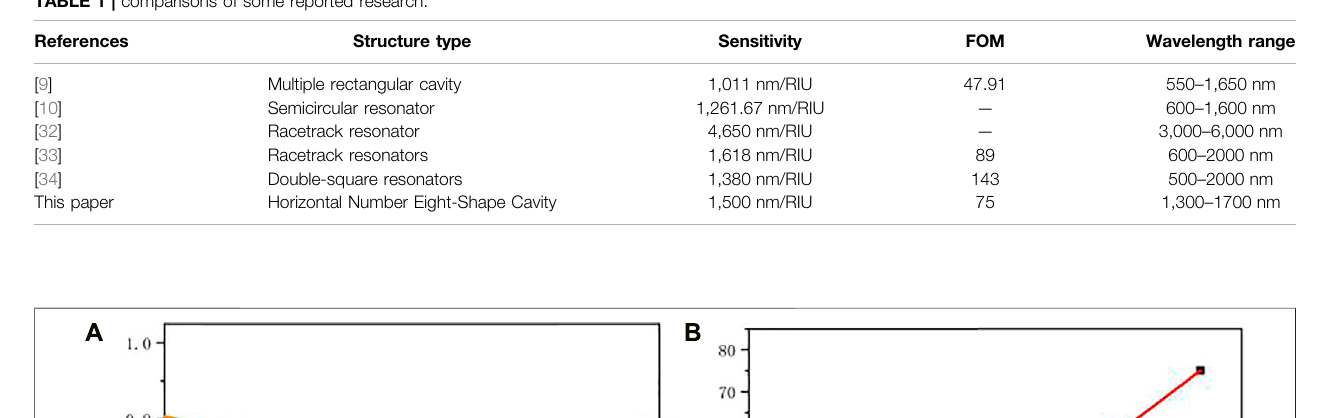
TABLE 1 | comparisons of some reported research.